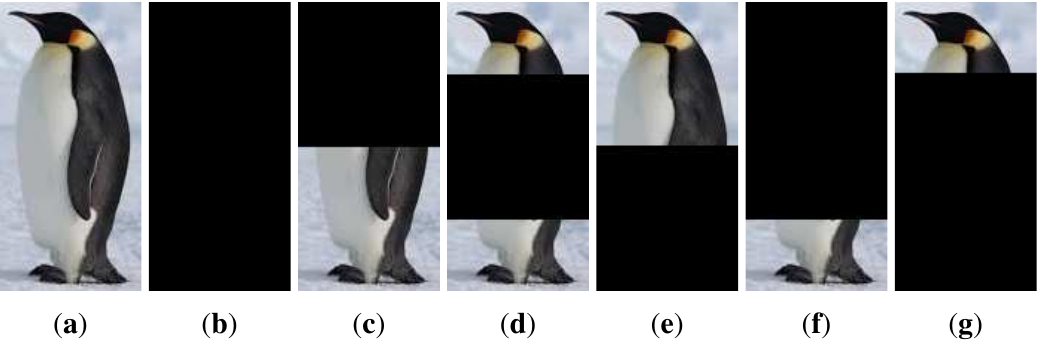
Illustration of the multiple-patches object representation. An object on the left is represented by six adaptive covariance descriptors computed from corresponding sub-regions on the right. Note that if the width of the object is greater than its height, a similar division is performed in the horizontal